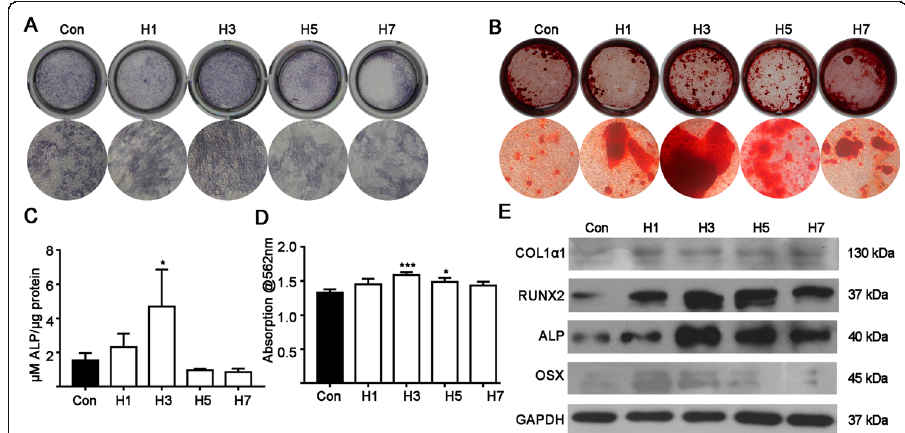
Fig. 2 The effect of continuous hypoxia for 1, 3, 5 and 7 days on ALP activity and matrix mineralization. a ALP staining on day 7. b Matrix mineralization (alizarin red staining) on day 14. c ALP activity on day 7. d Quantitative analysis of alizarin red staining. e Osteogenic differentiation marker (protein) expression. Data from quantitative analysis are the means ± SD from 5 independent experiments, n = 5. Significant effect of the treatment: * p < 0.05, ** p < 0.01 and *** p <